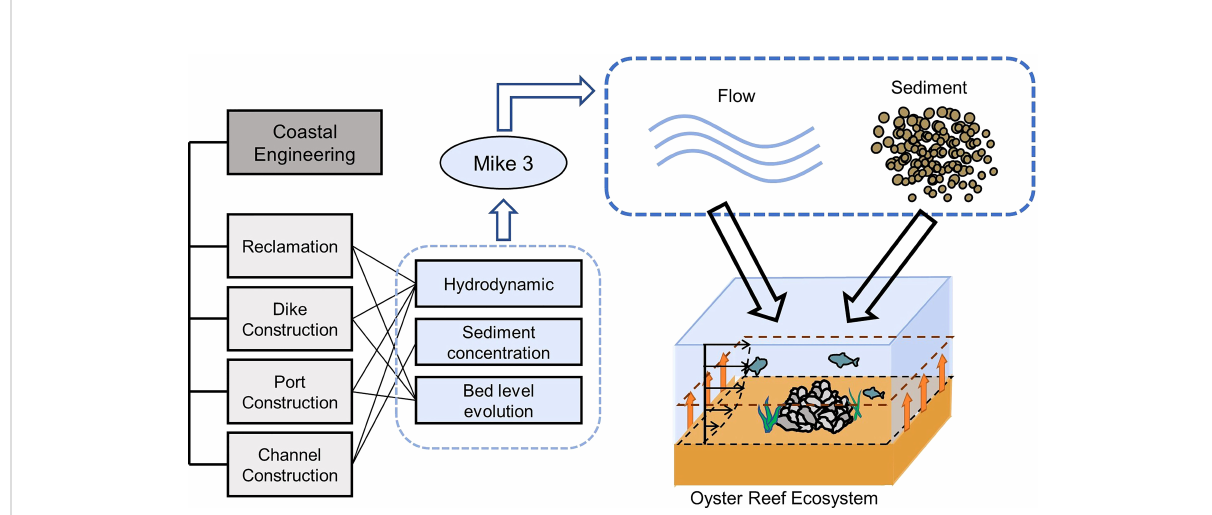
FIGURE 1 The framework of this study. The effects of the four main forms of coastal engineering on the three natural properties of waters and their relative relationships are shown. We abstracted these three natural properties as fl ow and sediment through the MIKE3 model and studied their variation at the three-dimensional scale to assess the impact of coastal engineering on oyster